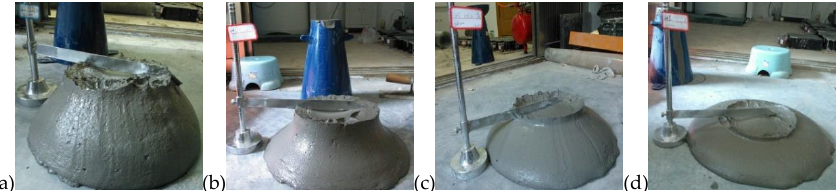
Figure 4. Slump tests of CPB mixture with different polynaphtalene sulfonate dosage: ( a ) 0, ( b ) 0.2%, ( c ) 0.4%, and ( d ) 0.8%. Table 4. The average slump of CPB with different dosages of polynaphtalene sulfonate. Polynaphtalene Sulfonate (%)